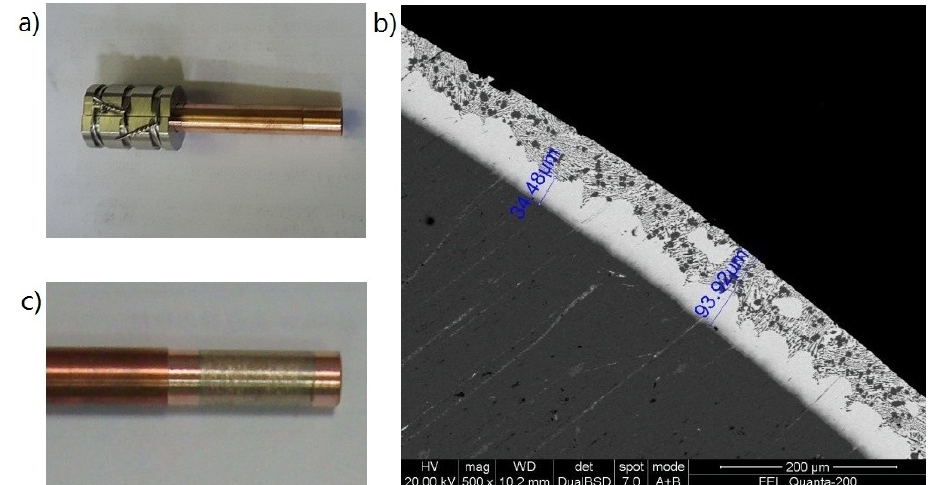
Figure 8. Images of the Cu-Cr-Zr cylinder vacuum-sintered by the solder wrapped by half sets and steel wire, ( a ) half sets and steel wire wrapped cylinder, ( b ) the cross-sectional SEM image of the solder sintered cylinder, and ( c ) the solder sintered cylinder after surface cutting.